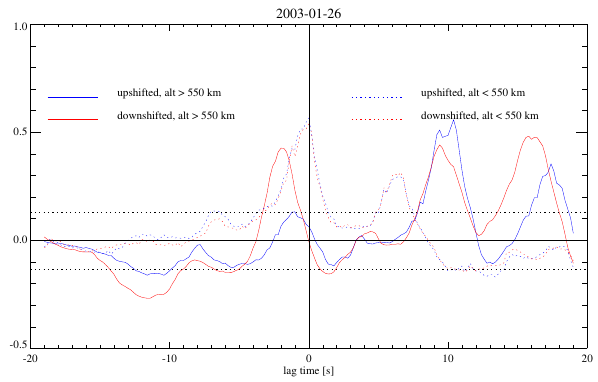
Fig. 6. Correlation between the in-beam luminosity and time series of received radar power from different regions of the radar spec- trum. The in-beam luminosity here is taken from the Odin imager mounted at the ESR site.